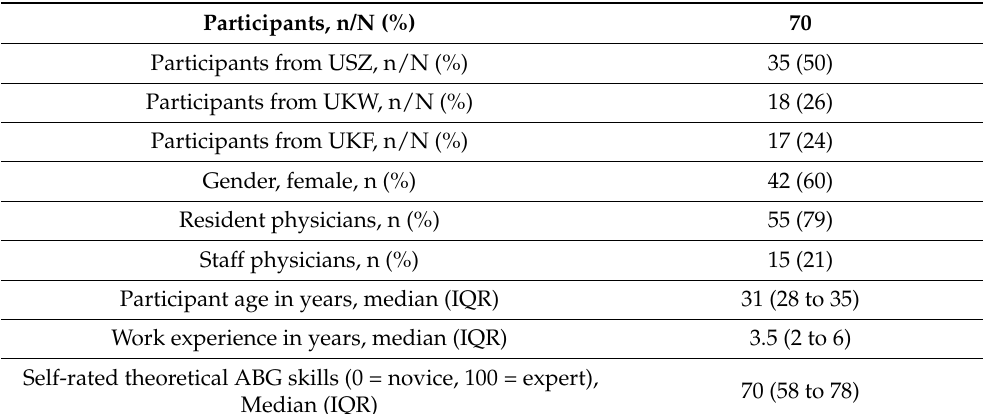
Table 1. Participant characteristics. USZ, University Hospital Zurich; UKW, University Hospital Wuerzburg; UKF, University Hospital Frankfurt; ABG, arterial blood gas; IQR, interquartile